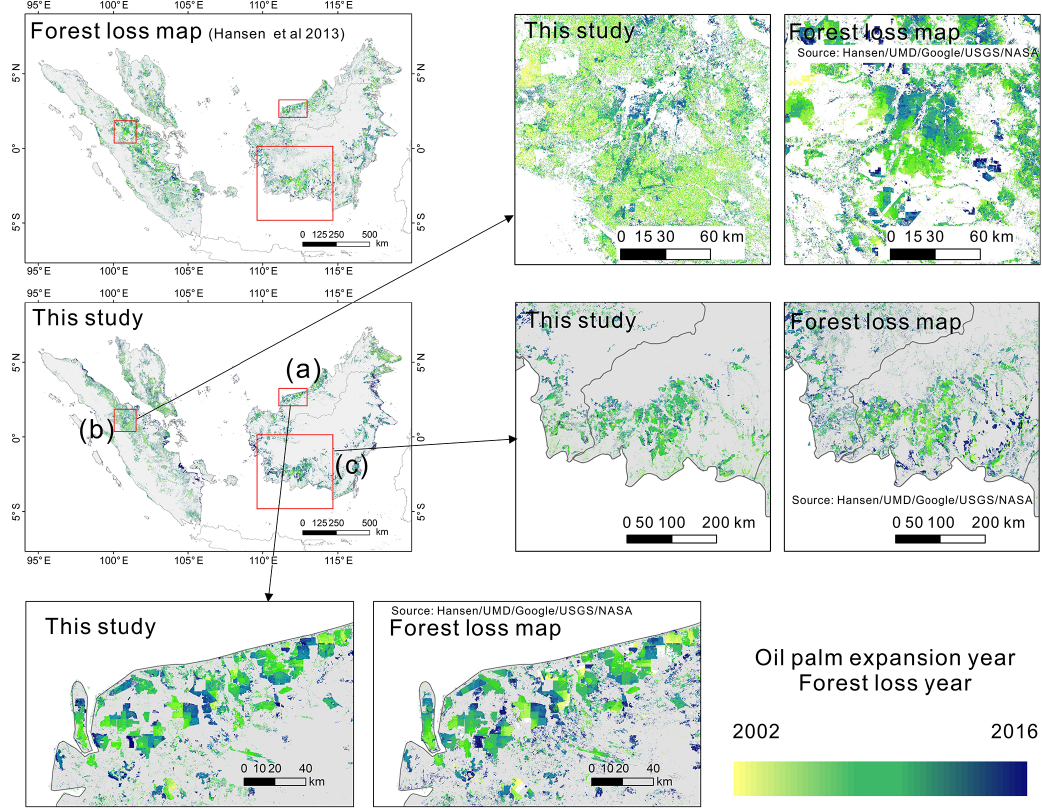
Figure 10. Comparison of oil palm expansion map in this study with the Landsat forest area loss map (Hansen et al.,